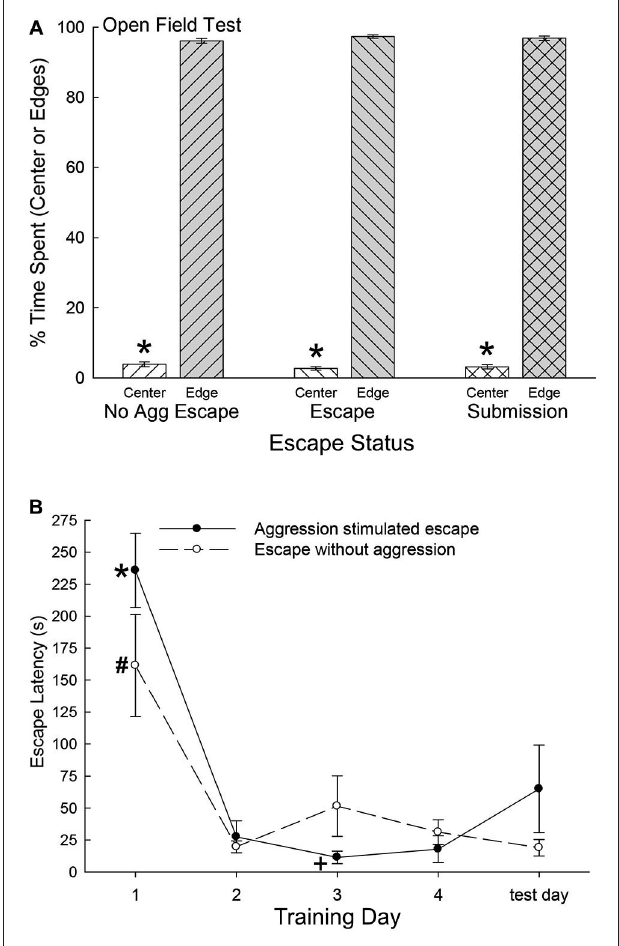
FIGURE 2 | (A) Similar open field anxiety. (B) Latency to escape diminishes quickly. (A) Mean ( ± SEM) percent time spent in the open center (white bars) and edge (gray bars) portions of the open field interior arena of the SAM apparatus (* indicates statistical significance between center and edge preference, p < 0.05) for No Aggression (left hatching; N = 7), Escape (right hatching; N = 11) and Submission (cross hatching; N = 32) groups. (B) Mean ( ± SEM) latency to escape for the animals exposed to social aggression significantly (* indicates statistical significance p < 0.05; N = 11) decreased after training day 1 ( ∼ 236 s) and they continued to escape faster (+, under ∼ 45 s) for the duration of the experiment (solid line). Mice exposed to only the open field portion of the SAM apparatus followed a similar pattern of escape latency and continued to escape significantly (# p < 0.05) faster for the reminder of the experiment (dashed